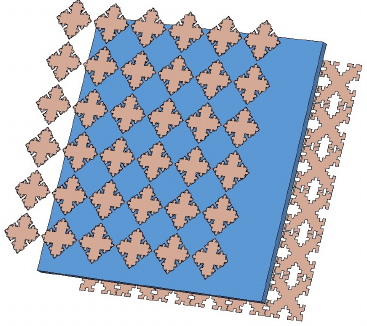
Figure 2. Geometry of the proposed fractal FSS.